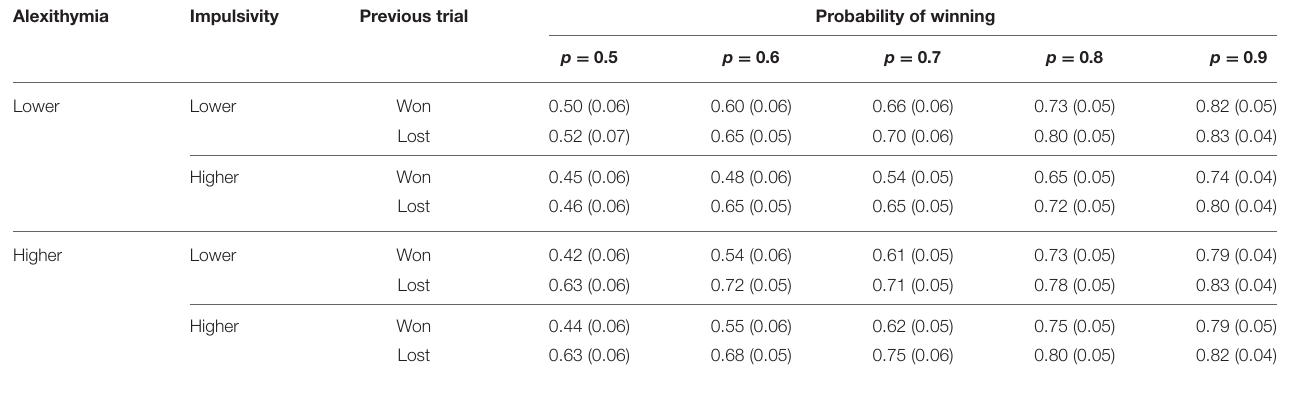
TABLE 7 | Means (and standard errors) of the proportion bet for alexithymia and impulsivity by outcome of the previous trial and probability of winning on the current trial.